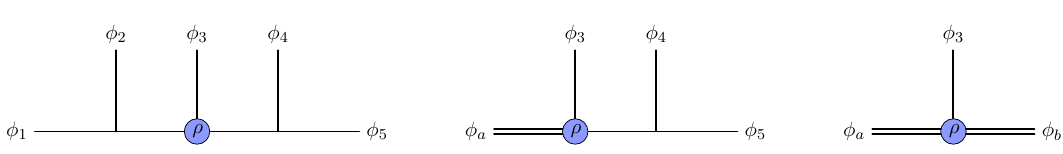
(center), and after a second OPE limit for fields φ a